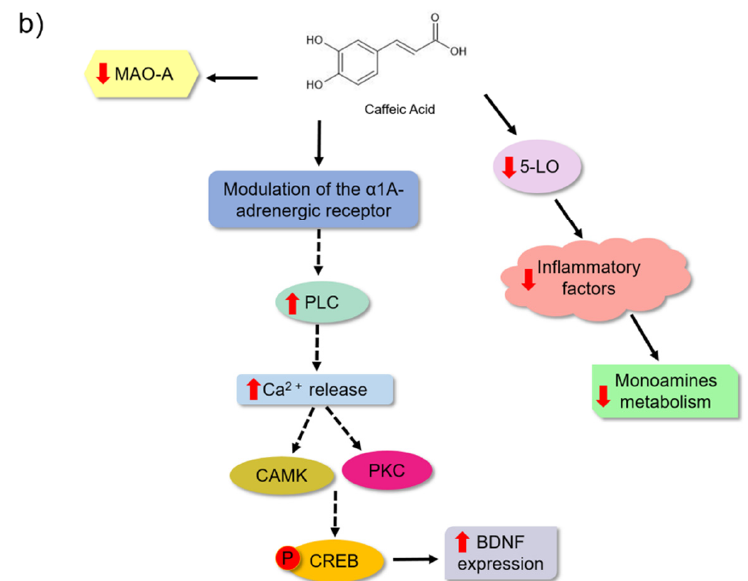
Figure 5. Possible mechanisms of action for chlorogenic acid ( a ) and caffeic acid ( b ) as antidepressants based on preclinical trials. ( a ) Chlorogenic acid may act by increasing levels of monoamine neurotransmitters as an inhibitor of monoamine oxidase isoform B, reducing neuroinflammation, reducing reactive oxygen species production, and improving host gut health by modulating the microbiota. ( b ) Caffeic acid has been shown to act through the modulation of α 1 adrenergic receptors. Takeda et al. [78] suggest that the activation of this receptor, which has a stimulator effect on cell signaling by increasing intracellular phospholipase C (PLC), promotes an increase in Ca 2+ concentration, thereby activating Ca 2 /calmodulin-dependent protein kinase (CAMK) and protein kinase C (PKC). These proteins promote phosphorylation of the cAMP response element-binding protein (CREB). Then, CREB regulates BDNF transcription [78]. Another action mechanism might be its inhibitory effect on the inflammatory lipoxygenase (5-LO) pathway, which may reduce monoamine neurotransmitter levels in the synaptic cleft. Additionally, this bioactive molecule might promote the inhibition of the activity of the MAO-A enzyme. The red arrows (up) indicate increased levels and (down) decreased levels. The solid black arrow indicates stimulation, whereas the dashed black arrow indicates possible activation (mechanism not directly evaluated in the study). The chemical structures were drawn using ChemSketch freeware, version 14.0 from ACD/Labs.